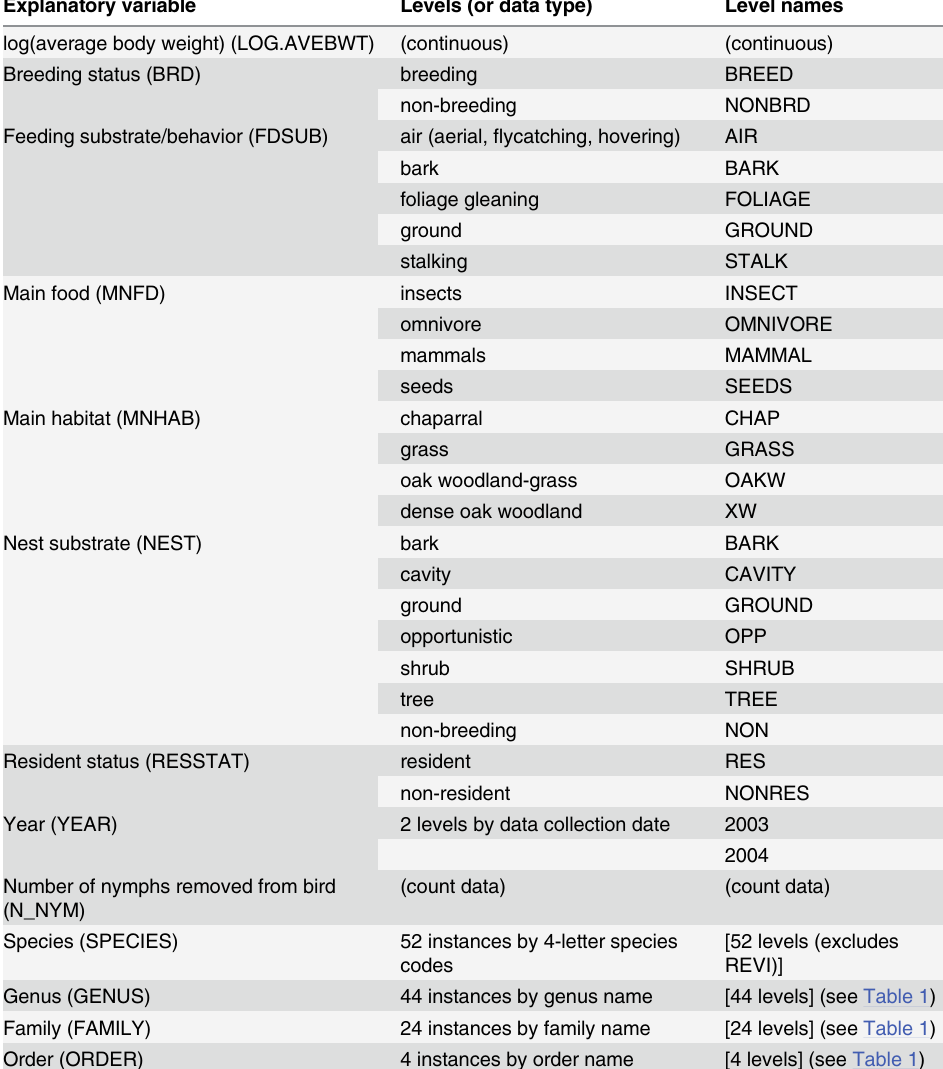
Table 2. Explanatory variables and their levels included in binomial and zero-in fl ated